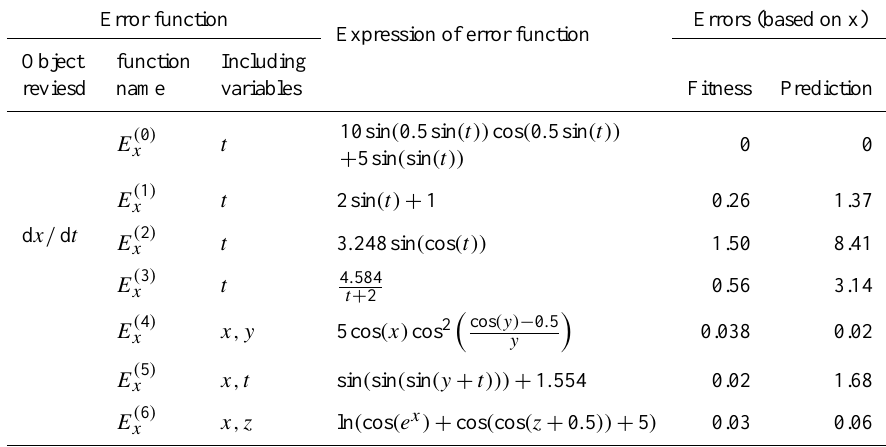
Table 2. Error functions and errors of the equations obtained by EM (for variable x